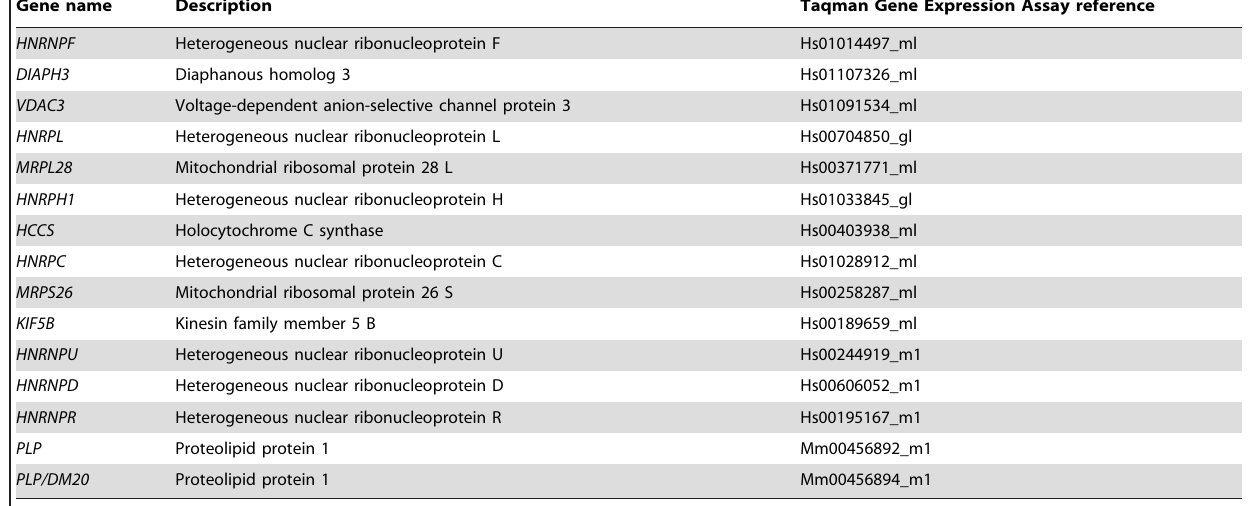
Table 2. List of the genes selected for QRT-PCR